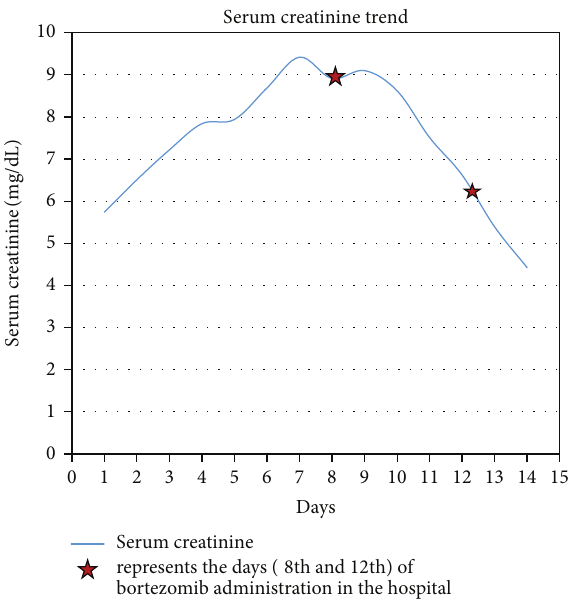
Figure 3: Serum creatinine trend over the course of the hospitaliza-